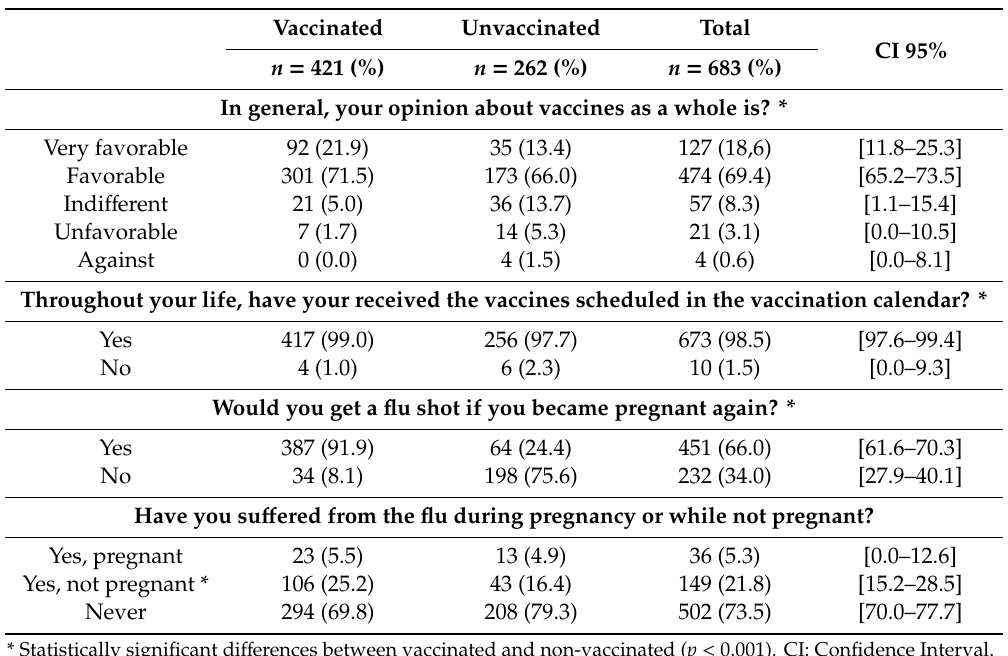
Table 2. Opinion on vaccines. Attitudes and experience related to influenza